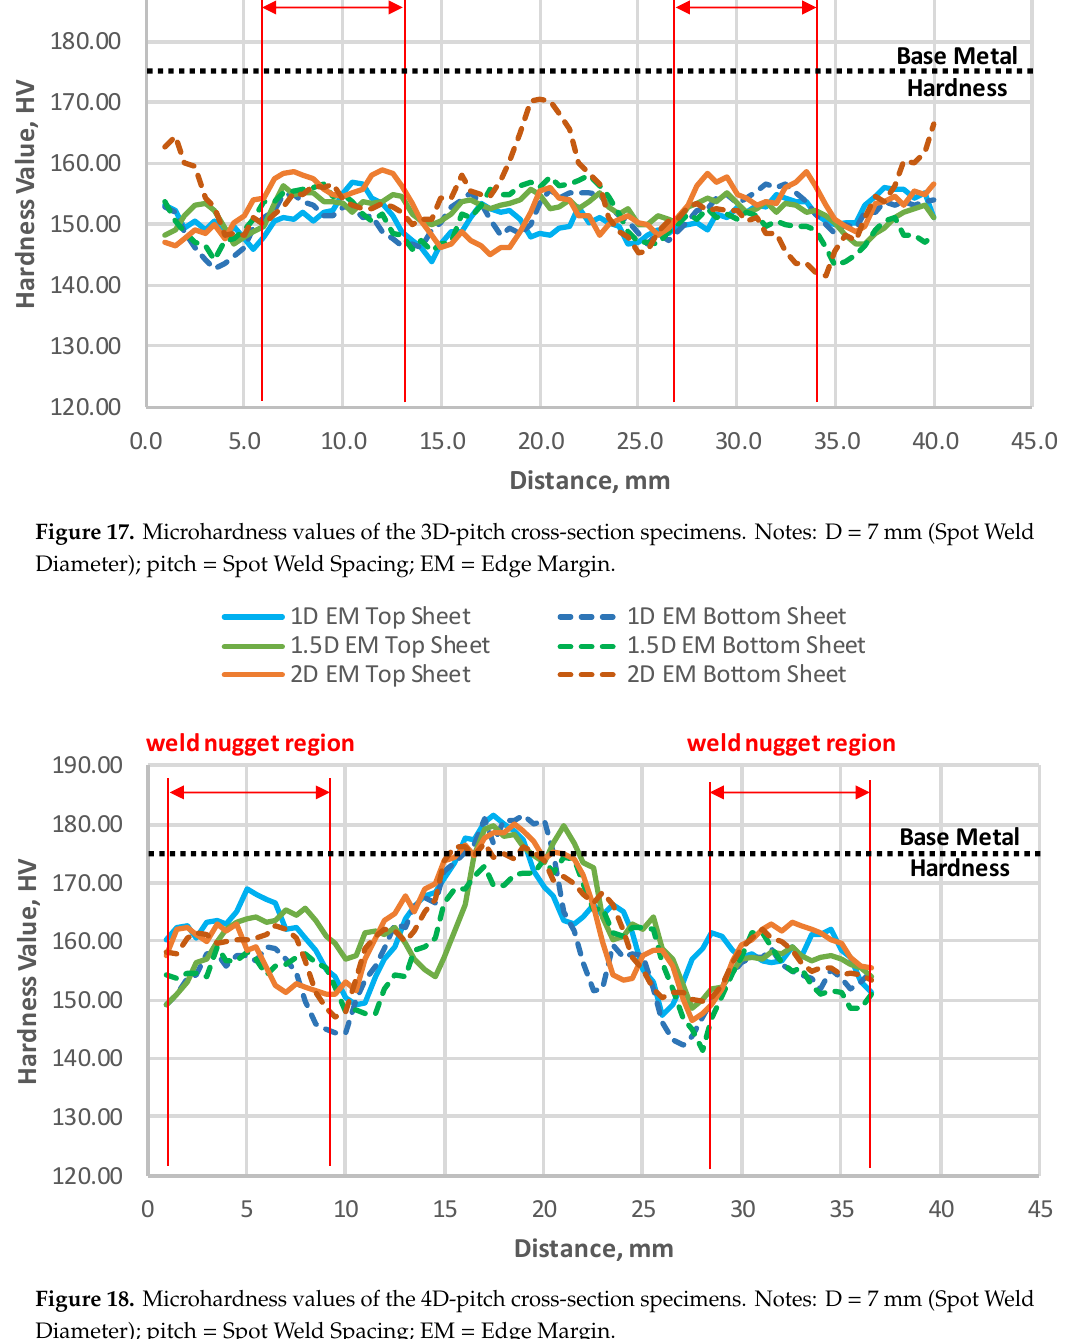
Figure 18. Microhardness values of the 4D-pitch cross-section specimens. Notes: D = 7 mm (Spot Weld Diameter); pitch = Spot Weld Spacing; EM = Edge Margin.